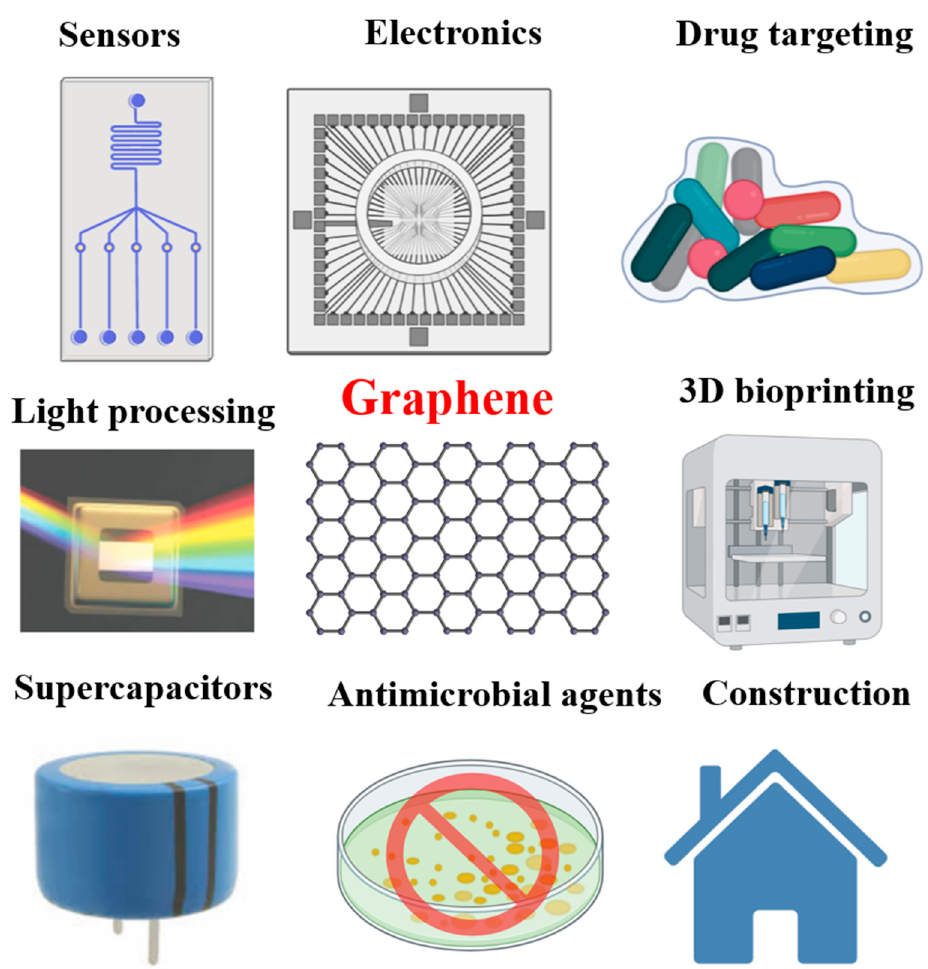
Figure 1. Potential application of graphene-based nanomaterials in industrial and biomedical fields.